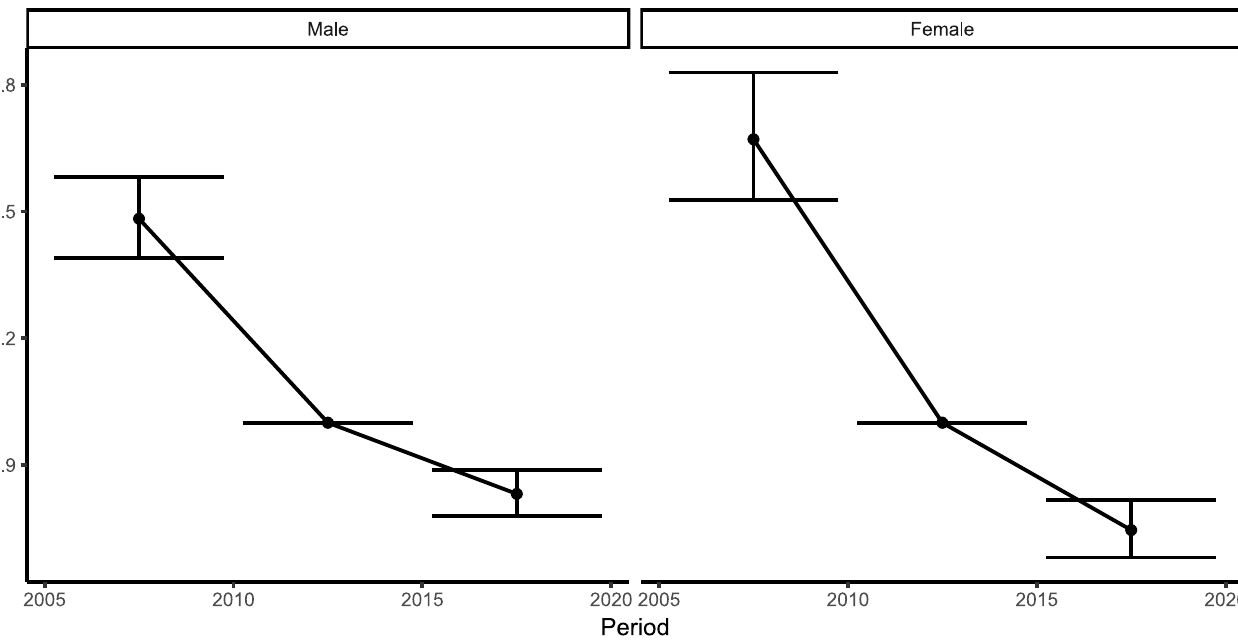
Figure 3. Period effects, Male ( left ) and Female ( right ). Relative risk of each period compared with the reference period — ratio of age-specific rates in each period relative to the reference period.